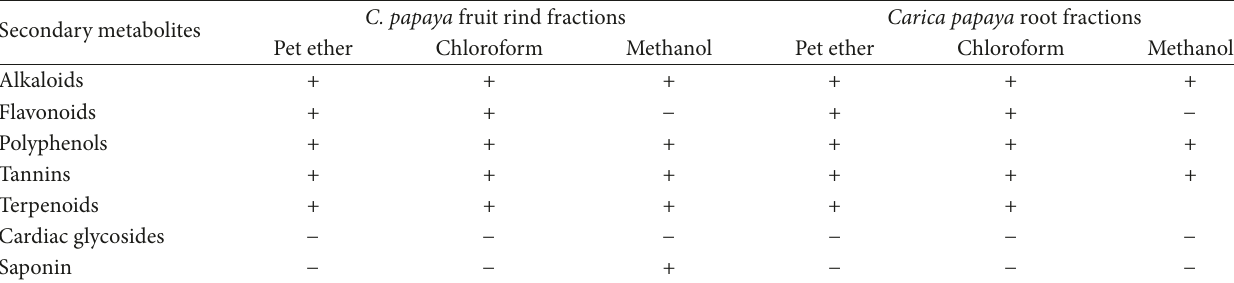
Table 7: Qualitative phytochemical screening of the solvent fractions of fruit rind and root of Carica papaya . Secondary